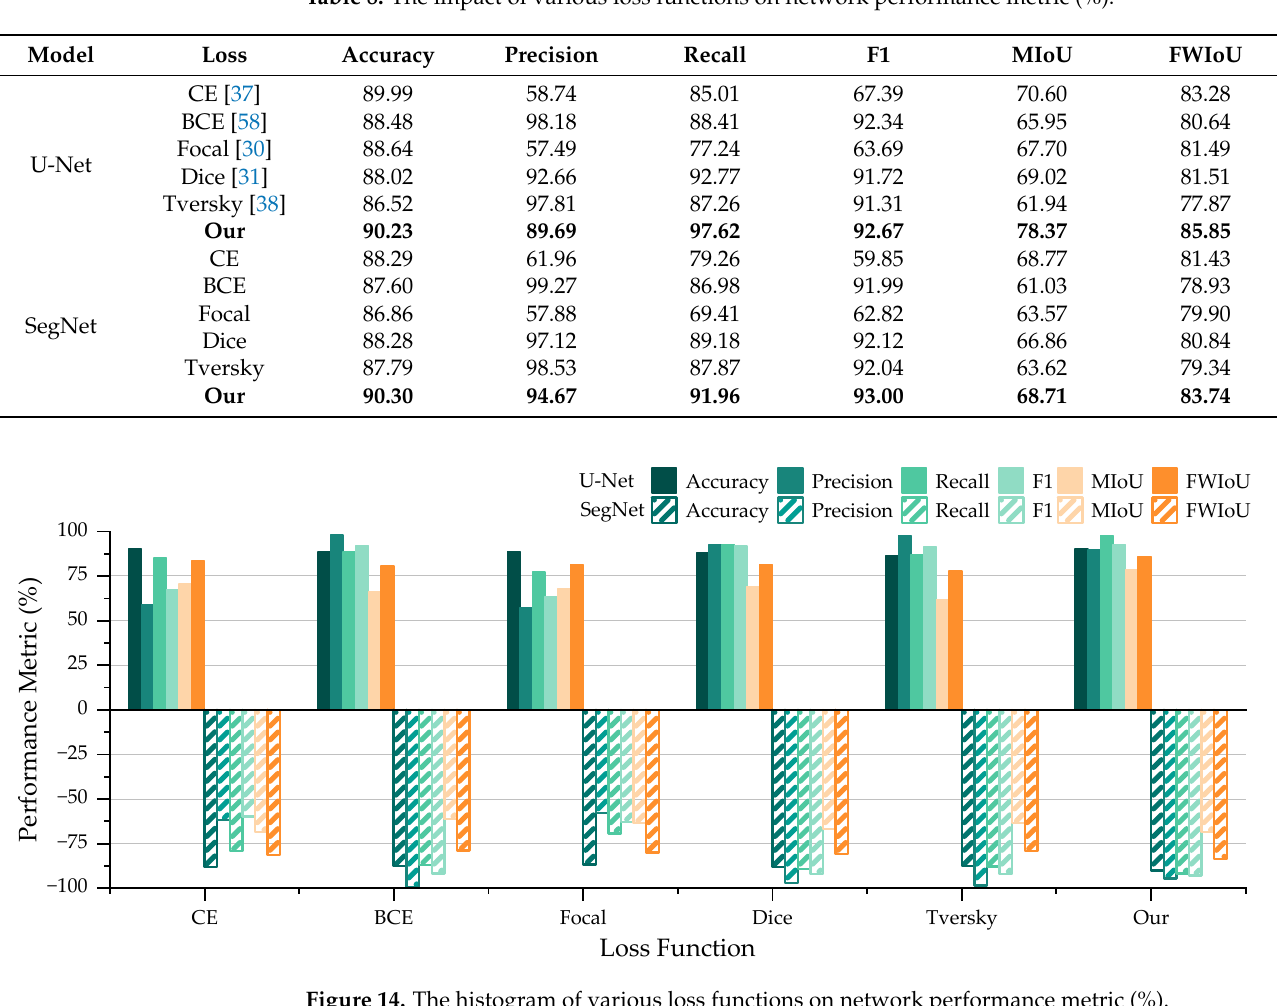
15a that the U-Net model performed the best using our loss function with an AUC of 0.97 on the ROC curve and the worst using Dice loss with an AUC of 0.88. According to Figure 15b, U-Net has the closest curve to our loss function and the BCE loss on the P–R curve, but the curve representing the red curve of our loss function contains a large area under the curve, so our loss function is better, while the curve of dice loss contains the smallest area under the curve, so the segmentation ability is inadequate.